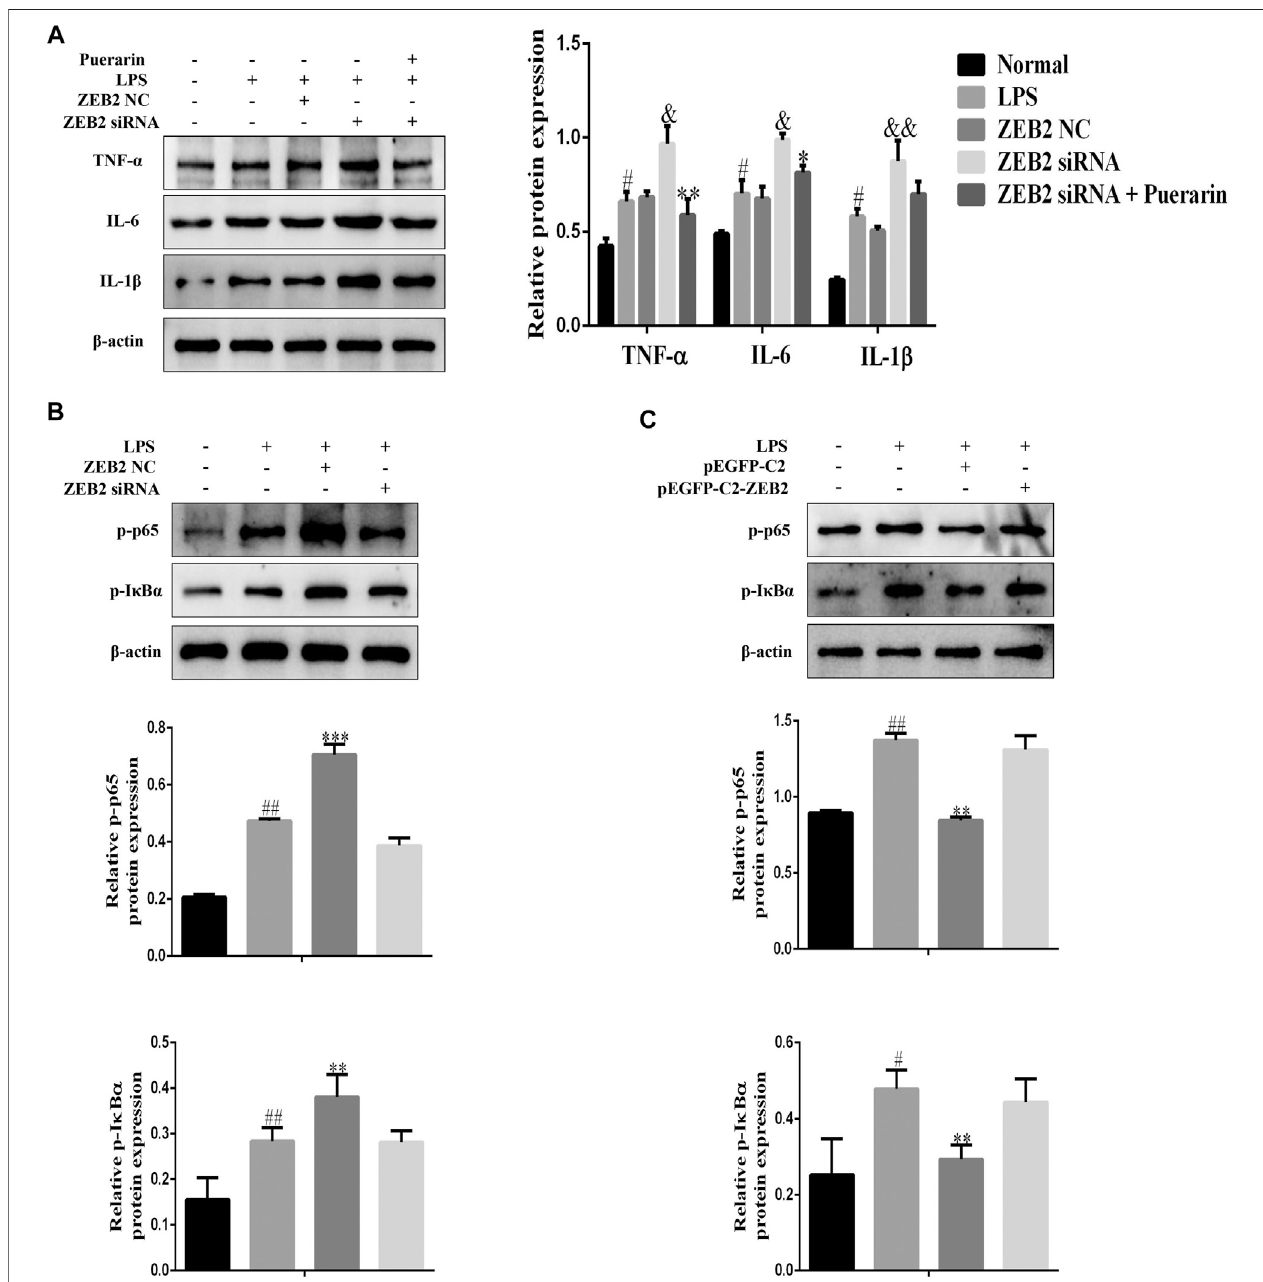
FIGURE 6 | ZEB2 inhibited the LPS-induced activation of the NF- κ B signaling pathway in L-02 cells. (A) : The expression levels of TNF- α , IL-6, and IL-1 β were detected using WB analyses in LPS-induced L-02 cells treated with PUERARIN and transfected with ZEB2 siRNA and pEGFP-C2-ZEB2. (B) and (C) : The protein expression levels of p-p65 and p-I κ B α were detected using WB analyses in LPS-induced L-02 cells transfected with ZEB2 siRNA and pEGFP-C2-ZEB2. The assays wereperformedatleastthreetimes,withsimilarresults.Dataareshownasthemeans ± SD( n (cid:2) 3)ofonerepresentativeexperiment; ###p < 0.001and ##p < 0.01, #p < 0.05 versus normal groups; **p < 0.01 and *p < 0.05 versus the LPS